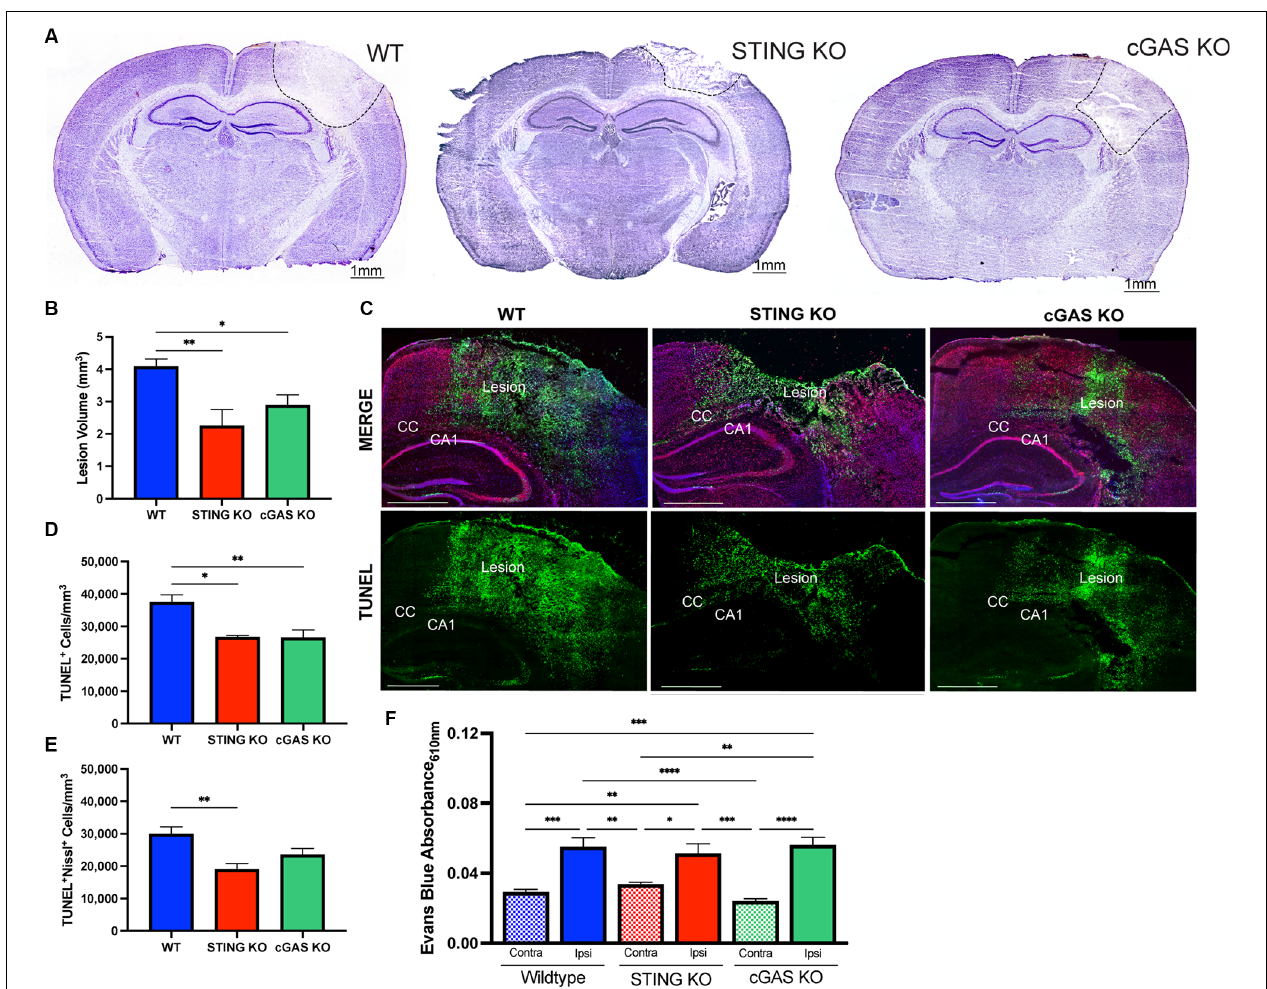
FIGURE 3 | Loss of endogenous cGAS and STING decreases lesion volume and cell death after TBI. (A) Representative images of Cresyl violet stained brains at 4x magnification. The dashed line indicates the lesion site. Scale bar = 1 mm. (B) Quantification of lesion volume in Cresyl violet stained WT, STING − / − , and cGAS − / − brains 24 h after CCI injury. n = 6–11 per genotype. (C) Representative confocal images of TUNEL (green), Nissl (red), and DAPI (blue) at 20x magnification of ipsilateral hemisphere of CCI-injured WT, STING − / − , and cGAS − / − animals. Scale bar = 1 mm. CC = corpus callosum. CA1 = hippocampal cornu ammonis 1. (D) Quantification of the density of apoptotic cells (indicated by cells labeled with TUNEL per mm 3 ) in the lesion site 24 h after injury in WT, STING − / − , and cGAS − / − mice. (E) The density of apoptotic neurons (indicated by cells positive for both TUNEL and Nissl per mm 3 ) in the lesion site 24 h after injury in WT, STING − / − ,